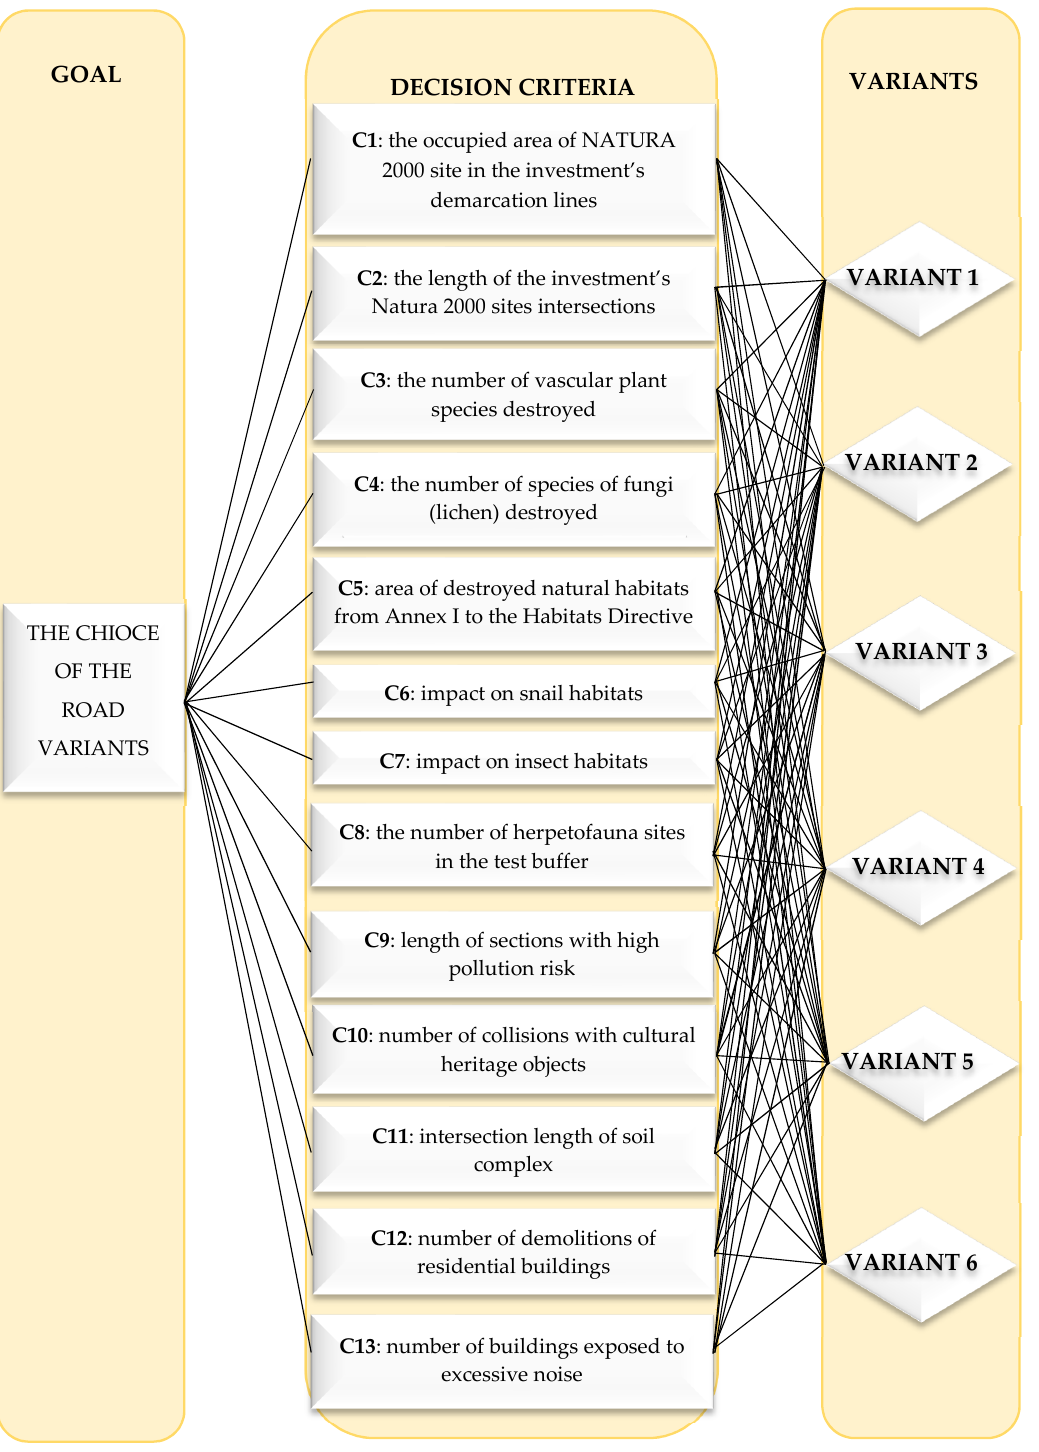
Figure 3. Hierarchical structure tree. Source: author’s work based on [75].